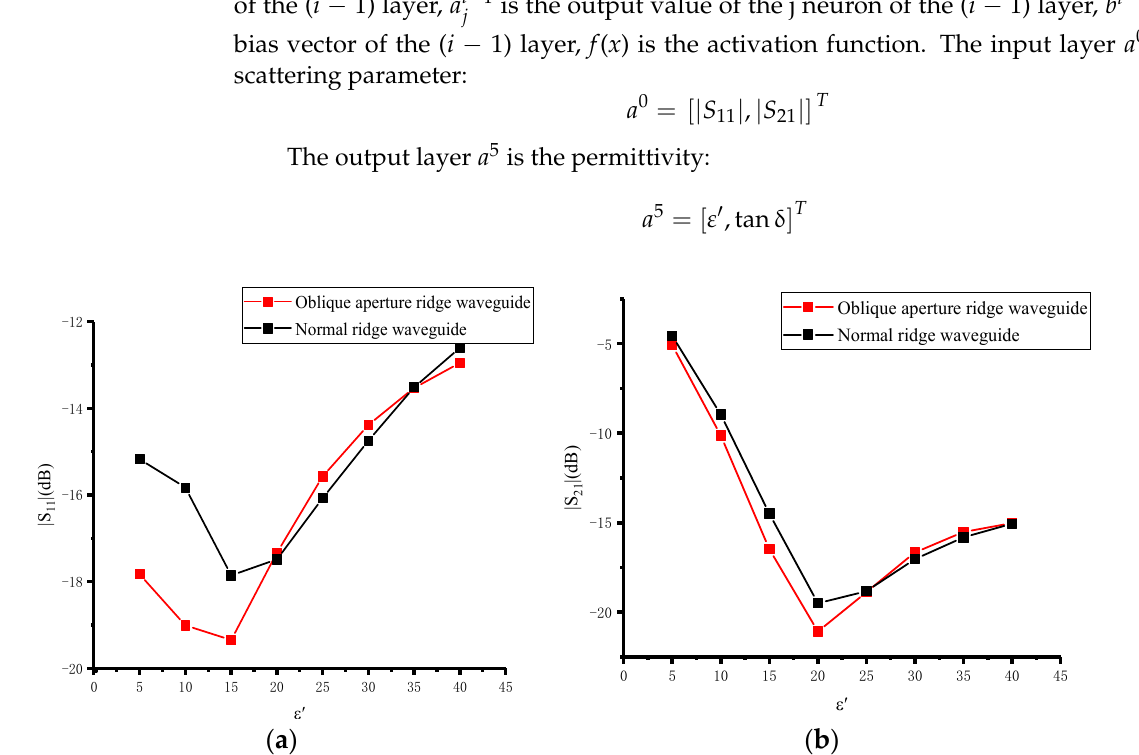
Figure 4. Sensitivity comparison results of oblique aperture ridge waveguide and normal ridge waveguide at tan δ = 0.8: ( a ) Sensitivity comparison results of | S 11 |; ( b ) sensitivity comparison re- sults of | S 21 |.